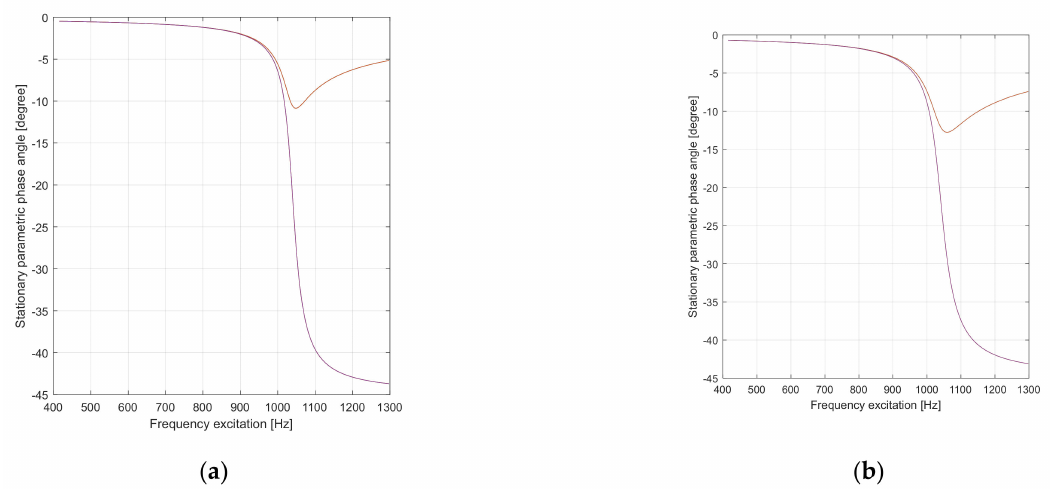
Figure 14. Stationary parametric phase angle Ψ of the tulip for χ nT = 0.25, where µ = 0.623 × 10 − 4 . ( a ) ζ = 0.0216. ( b ) ζ =